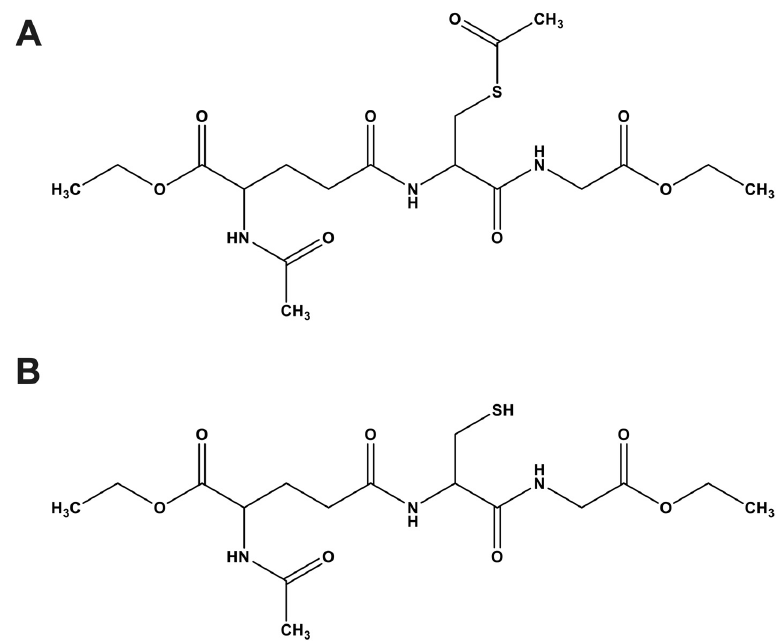
Figure 1. Structures of aggrelyte-1 and 1C. Structure of aggrelyte-1 ( S , N -diacetyl glutathione diethyl ester) ( A ) and aggrelyte-1C (N-acetyl glutathione diethyl ester) ( B ).